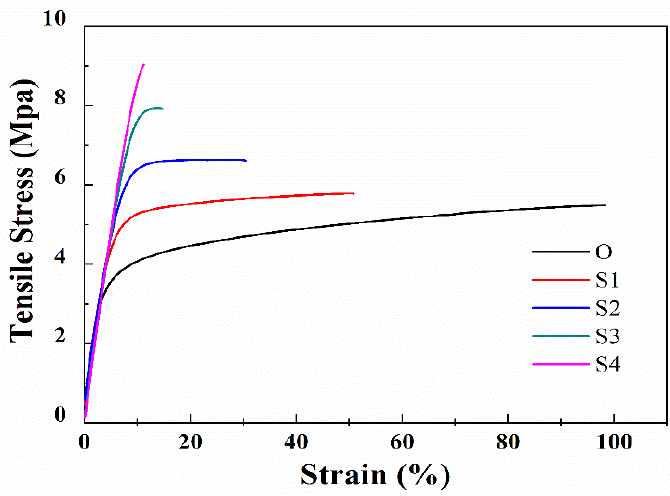
Figure 5. The stress-strain curves of the membrane samples stretched with di ff erent stretching